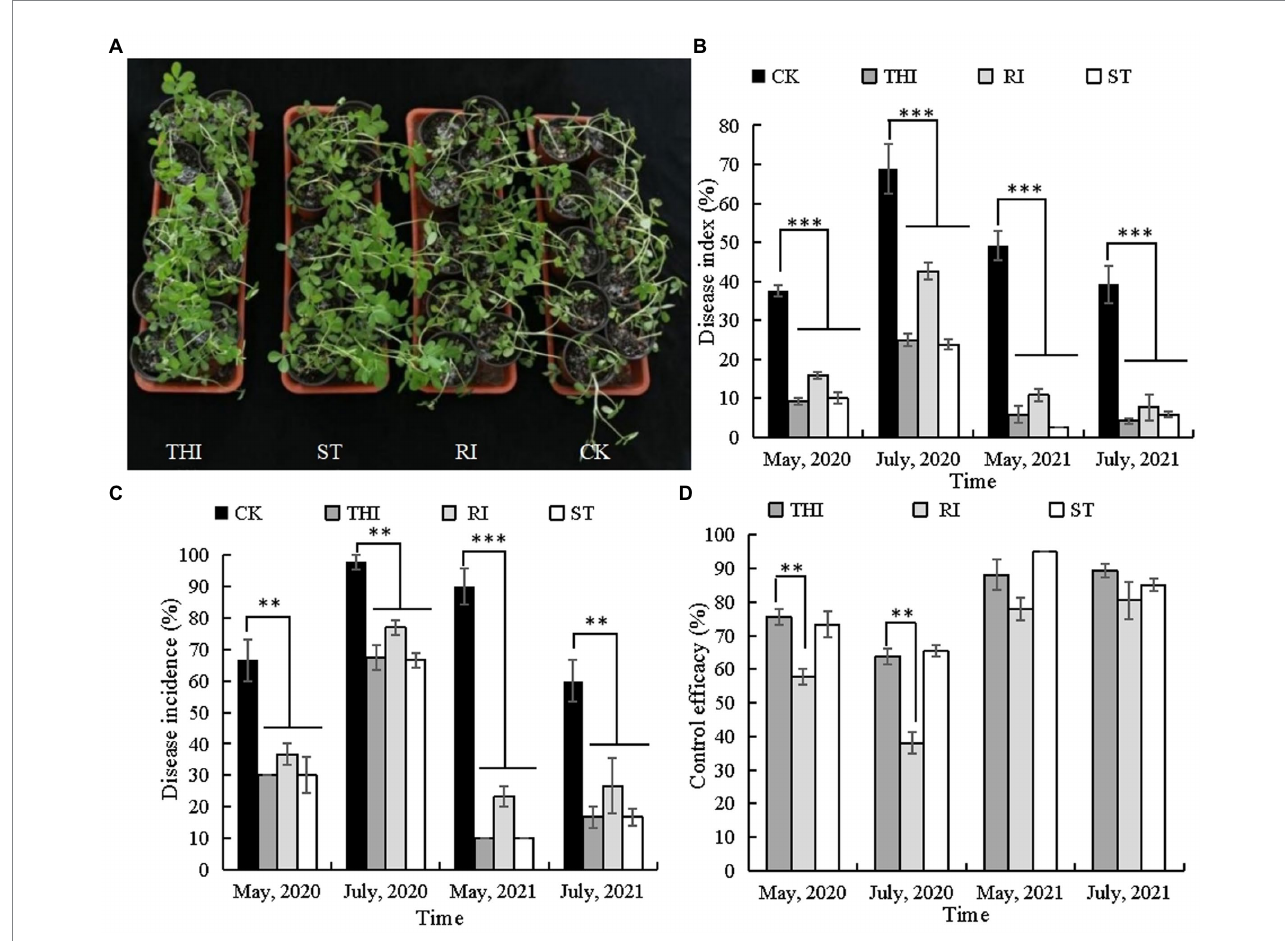
FIGURE 3 Bacillus velezensis CB13 reduced the disease incidence and disease index of peanut stem rot in pot assays. (A) Pot assays for stem rot disease control; (B) disease index; (C) disease incidence; (D) control effect. CK: infected peanut plants without treatment; THI: infected peanut plants sprayed with 20 mL of 240 g/L thifluzamide (diluted 500×); RI: infected peanut plants watered with 20 mL of bacterial inoculum (diluted 10×); ST: seeds were soaked in bacterial inoculum (diluted 10×) for 24 h before sowing. Data are the means ± SE of three repeated experiments. Significant differences are shown using asterisks (* p < 0.05, ** p < 0.01, and *** p <